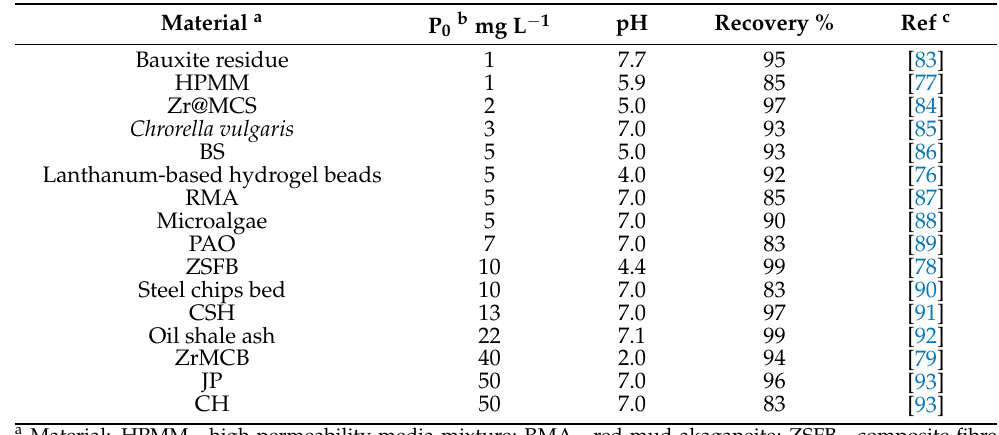
Table 4. Phosphorus removal with adsorption using adsorbents derived from agricultural wastes, metal industry wastes, and by advanced biological phosphorus removal with microorganisms. The table also shows the minimum concentration of the treated aqueous solution and the pH at which the highest removal efficiency has been